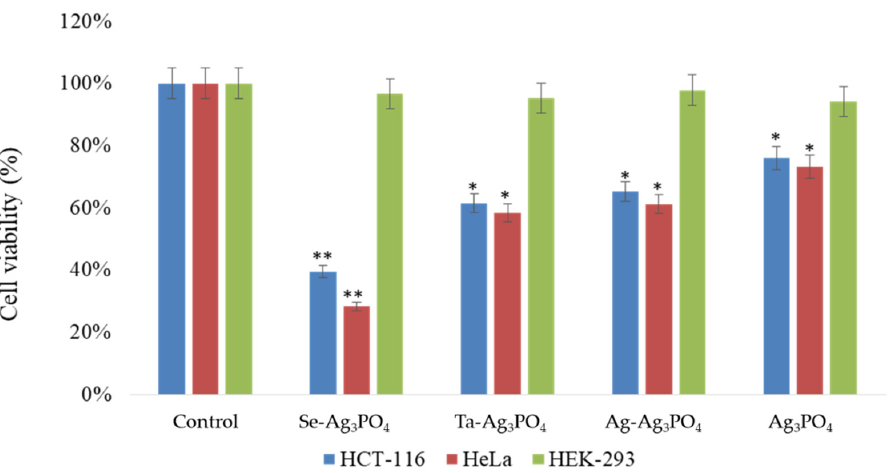
Figure 10. Cell viability using MTT Assay: It shows the impact of treatment of Ag 3 PO 4, Se-Ag 3 PO 4, Ag- Ag 3 PO 4, and Ta-Ag 3 PO 4 on HCT-116 and HeLa cell viability post 48 h treatment. * p < 0.05; ** p < 0.01. The inhibitory concentration (IC 50 ) of Ag 3 PO 4, Se-Ag 3 PO 4, Ag-Ag 3 PO 4, and Ta-Ag 3 PO 4 was computed. The IC 50 values for Ag 3 PO 4, Se-Ag 3 PO 4, Ag-Ag 3 PO 4, Ta-Ag 3 PO 4 on HCT-116 cells were 39.44, 28.33, 60.24, 58.34 µg/mL; whereas for HeLa cells, they were 65.25, 61.27, 75.52, 72.82 µg/mL, respectively (Figure 11).